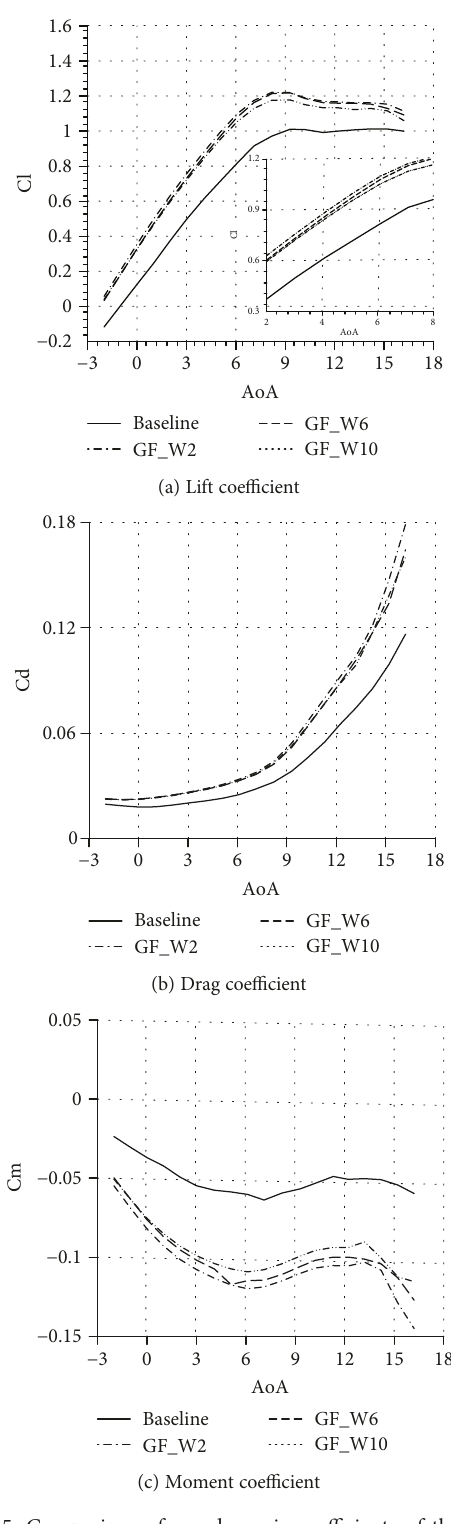
Figure 5: Comparison of aerodynamic coe ffi cients of the airfoils under di ff erent Gurney fl ap